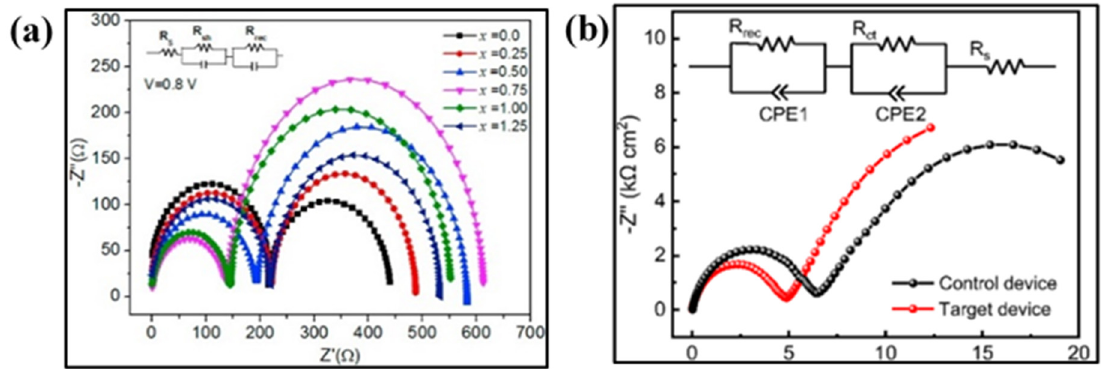
Figure 9. ( a ) Nyquist plots with different DEA molar ratios ( x ), measured at a bias of 0.8 V in the dark. Reproduced with permission from [71]. Elsevier, 2018. ( b ) Nyquist plots of HTM-free monolithic PSC with SnO 2 as ETL (Control device) and bi-layered ZTO as ETL (Target device). Reproduced with permission from [66]. American Chemical Society, 2019.